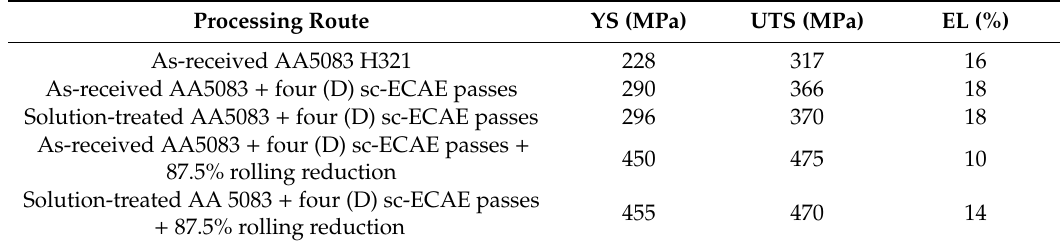
Table 2. Mechanical properties of AA5083. YS—yield stress; UTS—ultimate tensile strength; EL— elongation.